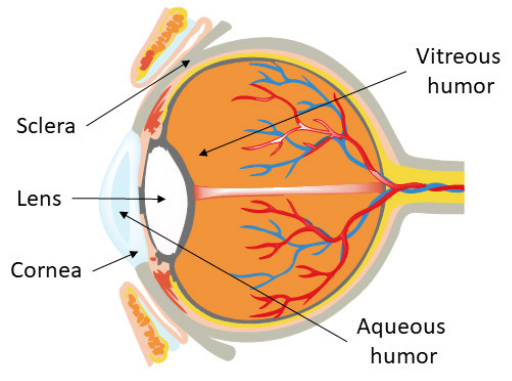
Figure 1 . Anatomical structure of the eyeball. Figure 1. Anatomical structure of the